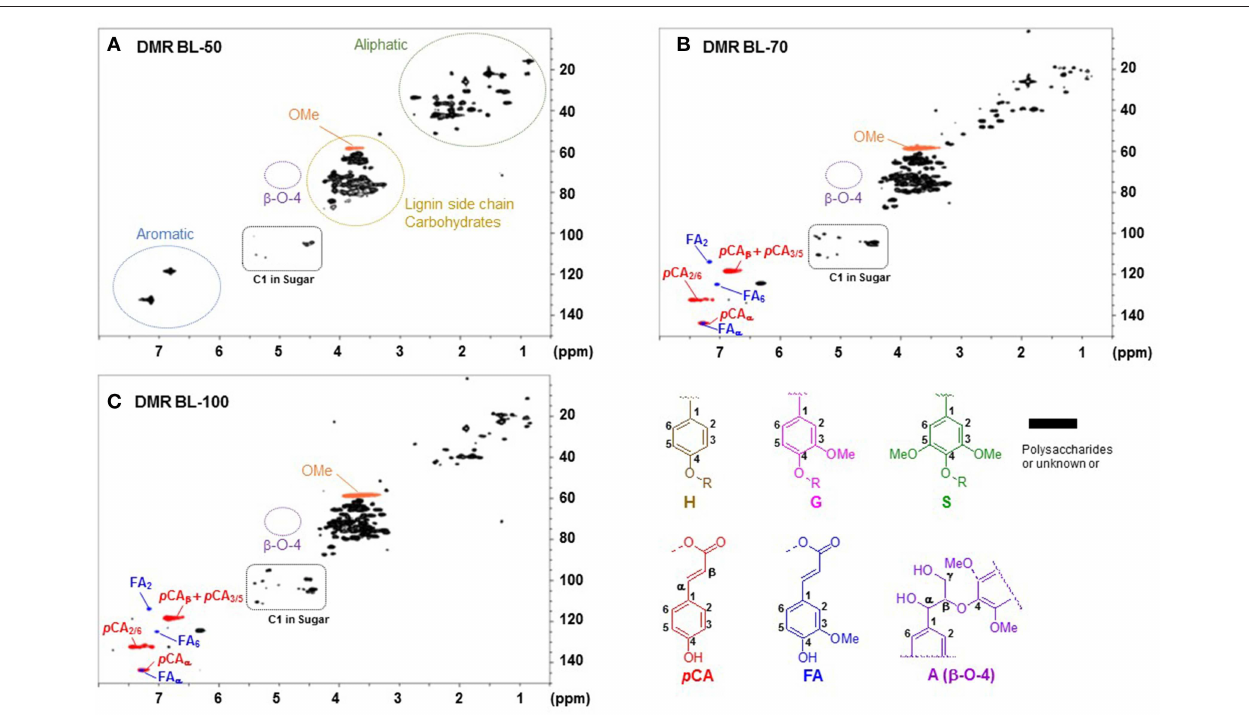
capacity in nature, enzymatically breaking down oligomers into monomers should be explored. Since more xylo-oligomers were released into black liquor with the higher loading of NaOH